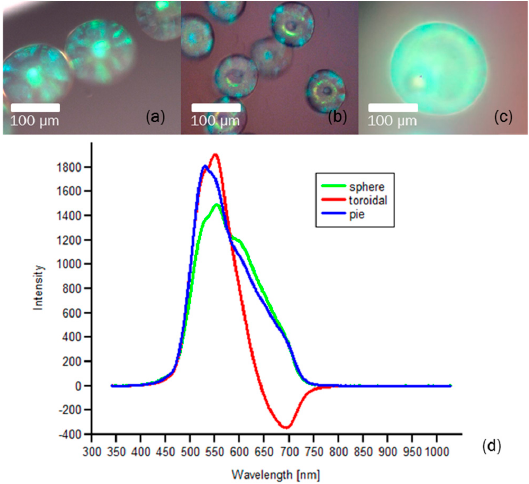
Figure 5. ( a – c ) Optical images and ( d ) reflectance spectrum of photonic crystal particles with different shapes.